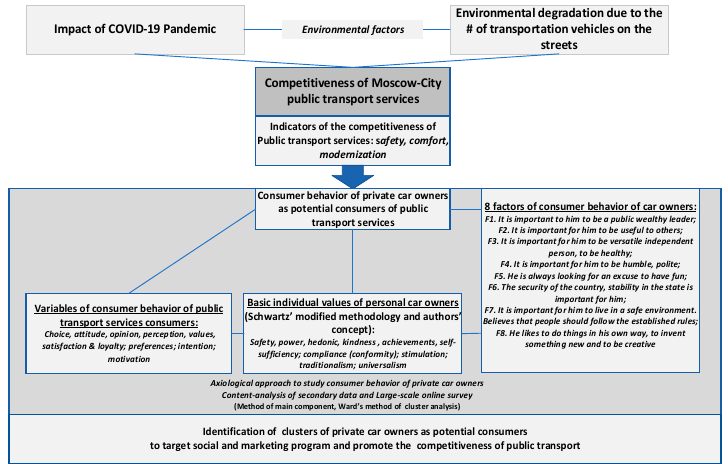
Figure 1. The conceptual research model of the assessment of the competitiveness of public transport servicescombinedtheimpactoftheenvironmentalfactorsandpotentialconsumers’behavior(composed (composed by the authors). by the